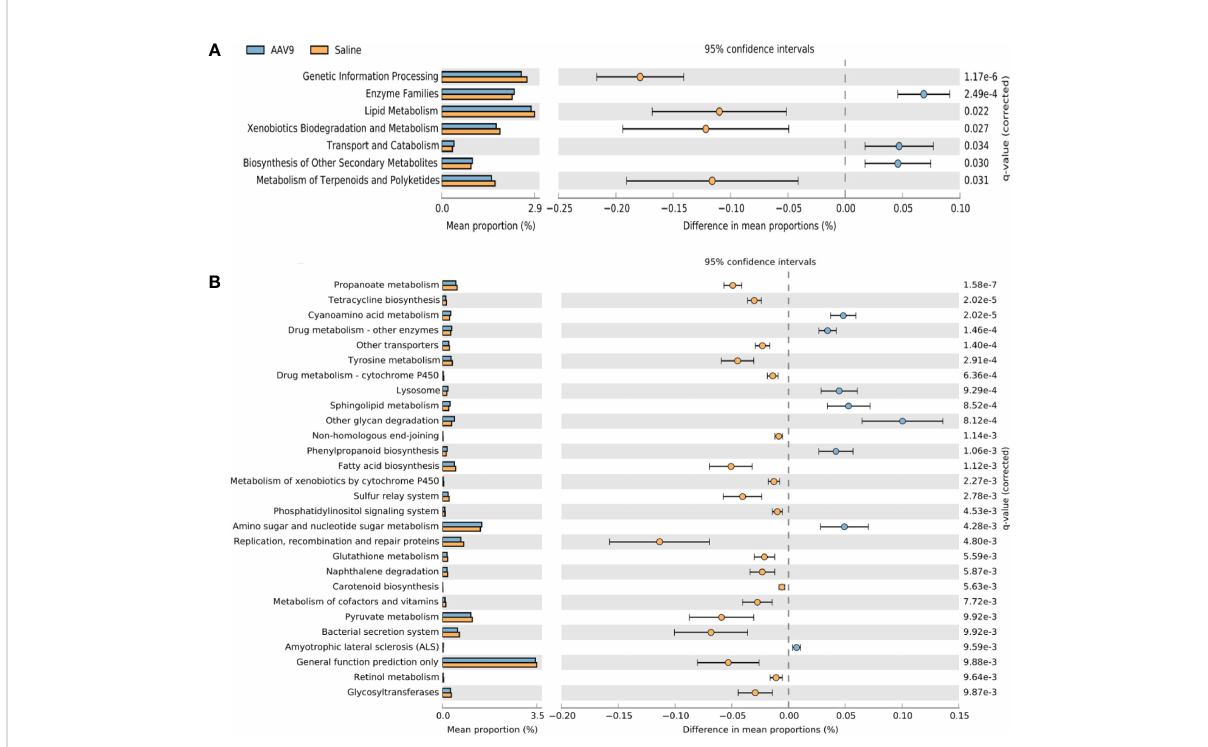
FIGURE 7 Prediction of PICRUSt function of rat faecal microbiota after AAV9 IP injection. STAMP software was used to perform statistical calculations and analyses and to visualize different KEGG pathway levels. (A) KEGG level 2 ( P < 0.05); (B) KEGG level 3 ( P <